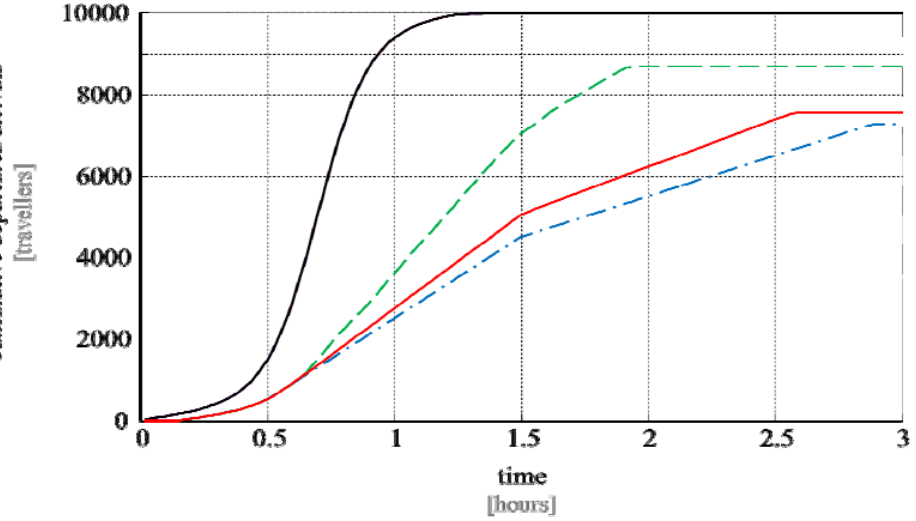
Figure 10. Cumulative departures (upper line) and arrivals (lower coloured lines): red solid line, information level 3; green dashed line, information level 8; blue dash-dotted line, information level 10